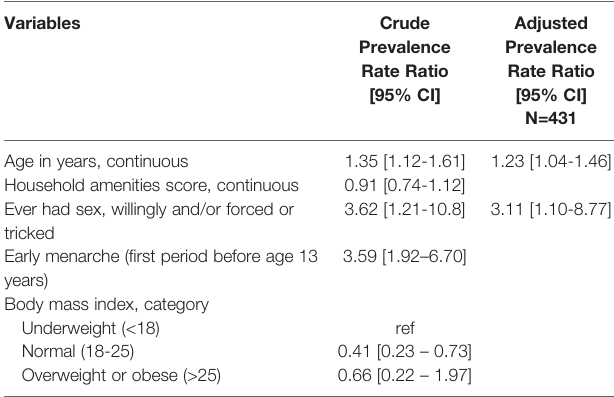
TABLE 6 | Results of poisson regression with robust variance estimate and random effect for school: crude and multivariable adjusted associations of sociodemographic and behavioral factors with non-ulcerative sexually transmitted infection.